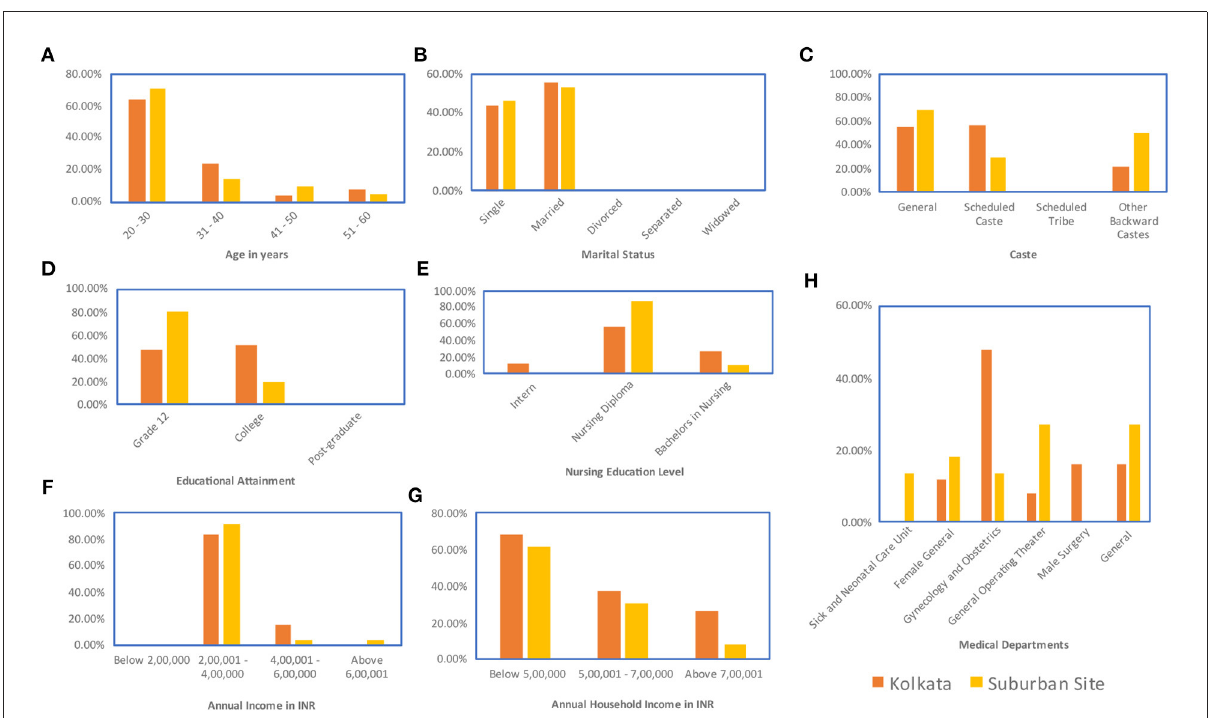
FIGURE2 Demographic data for nurse respondents: (A) Age (B) Marital status (C) Caste (D) Educational attainment (E) Nursing education pursued—within the Indian system, trainee nurses can work as interns in the hospital during their nursing training period, a two-year program is available for nurses to get their diploma in nursing, some nurses chose to do this after they receive an undergraduate bachelor’s degree in another field, and a four-year undergraduate bachelor’s degree in nursing is also available for nurses (F) Annual income (G) Annual household income (H) Medical